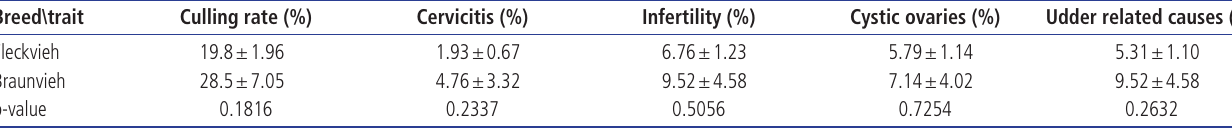
SEM, standard error of the